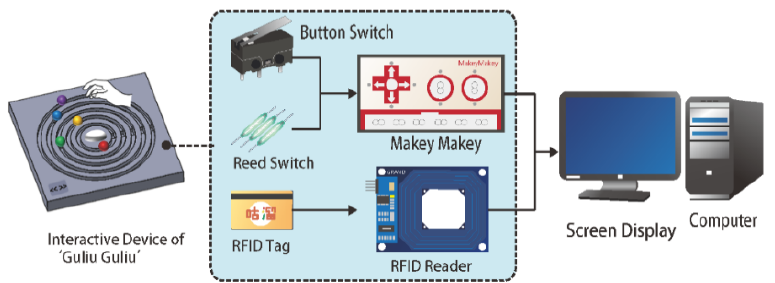
Figure 4. The Architecture of the proposed interactive device with a “Guliu Guliu” game.